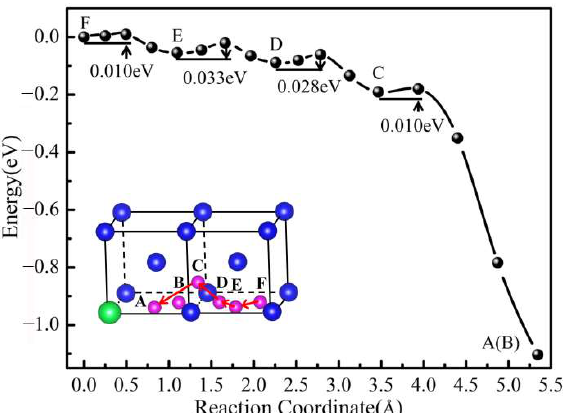
Figure 6. Diffusion barrier for He moving from a far TIS (F site) to TIS (A site) near Y in W-Y system, and the atomic model diagram represents the migration path of He. The blue, green, and purple balls represent W, Y, and He atoms, respectively.